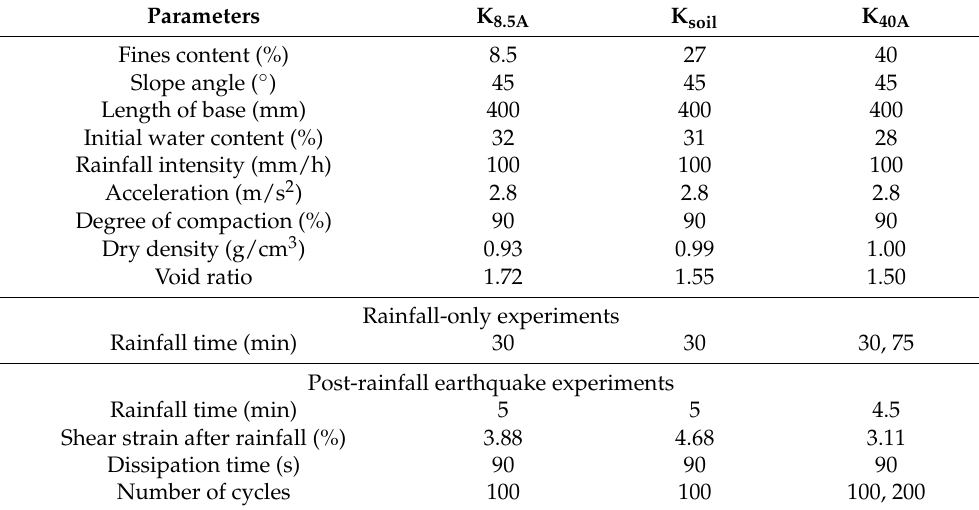
Table 4. Test conditions in this Kawamura and Miura (2013) [4] monitored the failure phenomenon of the model